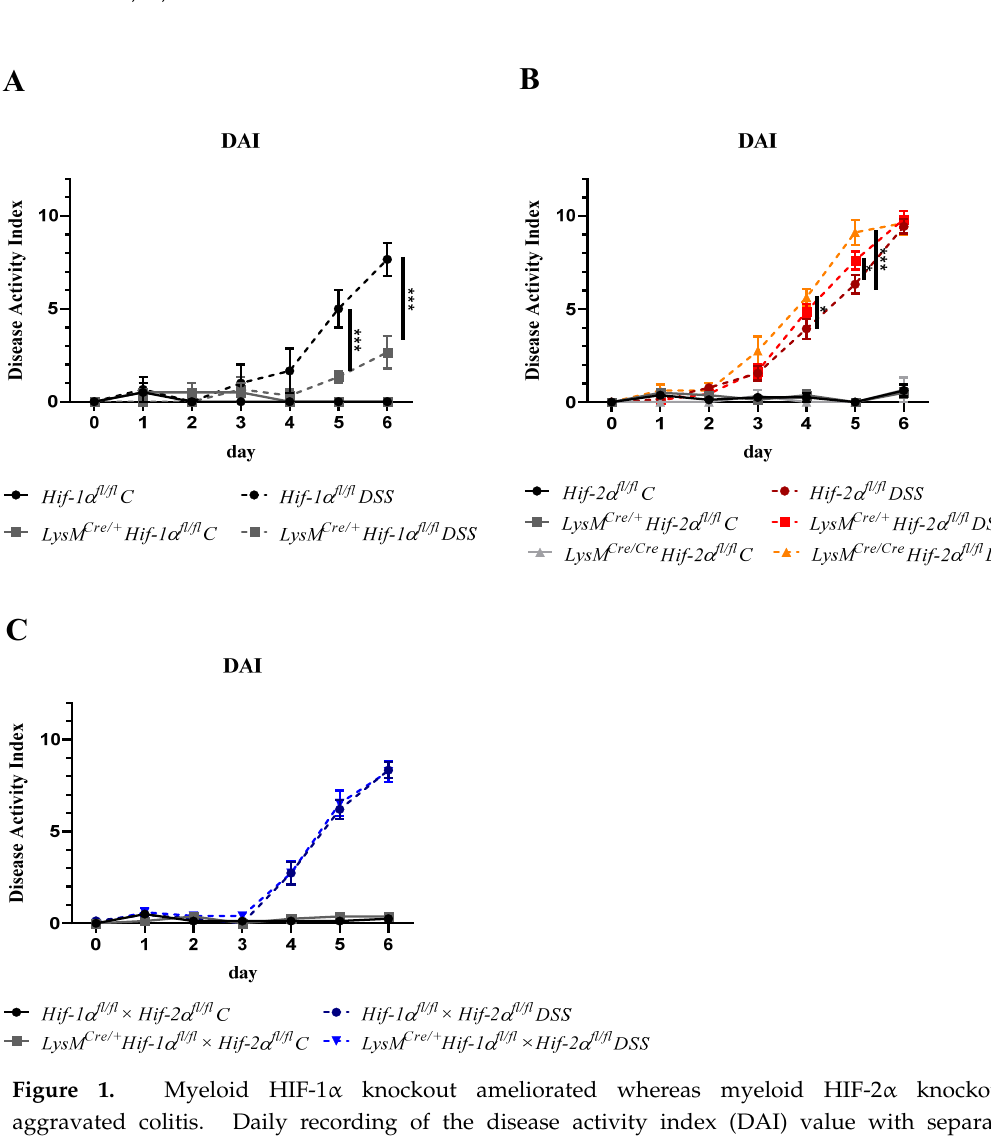
Figure 1. Myeloid HIF-1 α knockout ameliorated whereas myeloid HIF-2 α knockout aggravated colitis. Daily recording of the disease activity index (DAI) value with separate presentation for the different animal strains with and without dextran sodium sulfate (DSS) treatment. Statistical analysis was performed with a 2-way ANOVA (mean values ± SEM; ( A ): n (C) = 2, n (DSS) = 3; ( B ): n (C) = 3 ( LysM Cre/Cre Hif-2 α fl/fl )/8 ( Hif-2 α fl/fl ; LysM Cre/+ Hif-2 α fl/fl ), n (DSS) = 8 ( LysM Cre/Cre Hif-2 α fl/fl )/18 ( Hif-2 α fl/fl ; LysM Cre/+ Hif-2 α fl/fl ); and ( C ): n (C) = 7, n (DSS) = 14). *: p < 0.05; ***: p < 0.001.